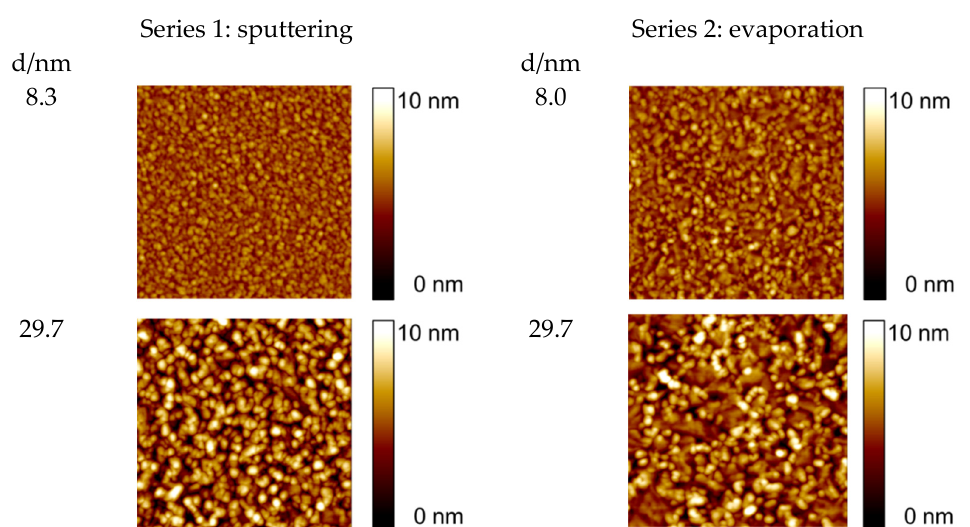
Figure 5. Selected AFM images of the metal films surface morphology. The mentioned thicknesses correspond to those obtained from XRR.